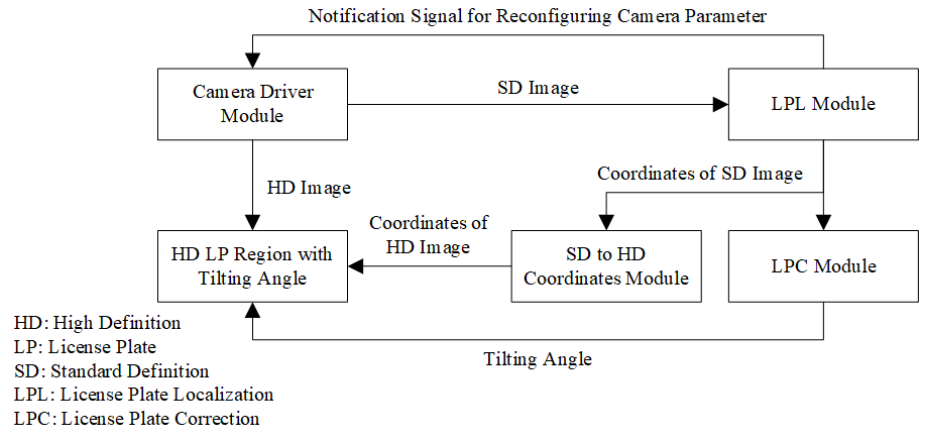
Fig. 1. High Definition License Plate Localization and License Plate Correction block diagram